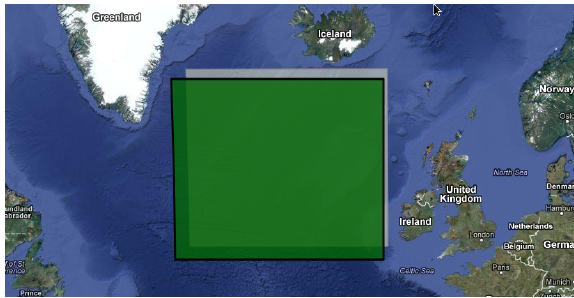
Fig. 1. The areas in the North Atlantic ocean for analysing windi- ness (dark green) and significant wave height (light grey) a corrected dataset with resolution 1 . 5 ◦ × 1 . 5 ◦ was used